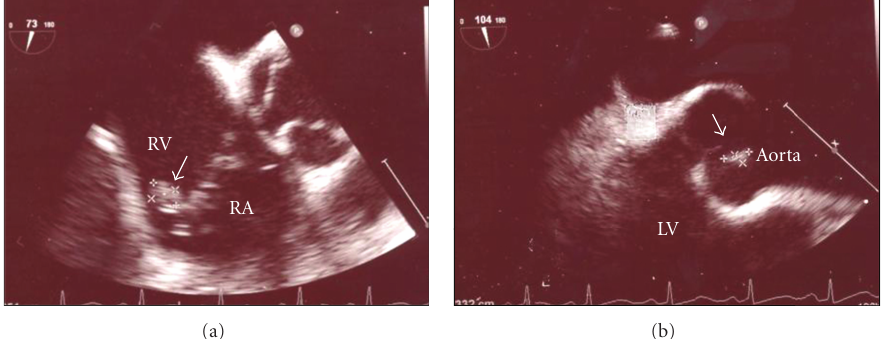
Figure 2: Transesophageal echocardiogram showing tricuspid (a) and aortic valve vegetations (b) consistent with endocarditis.